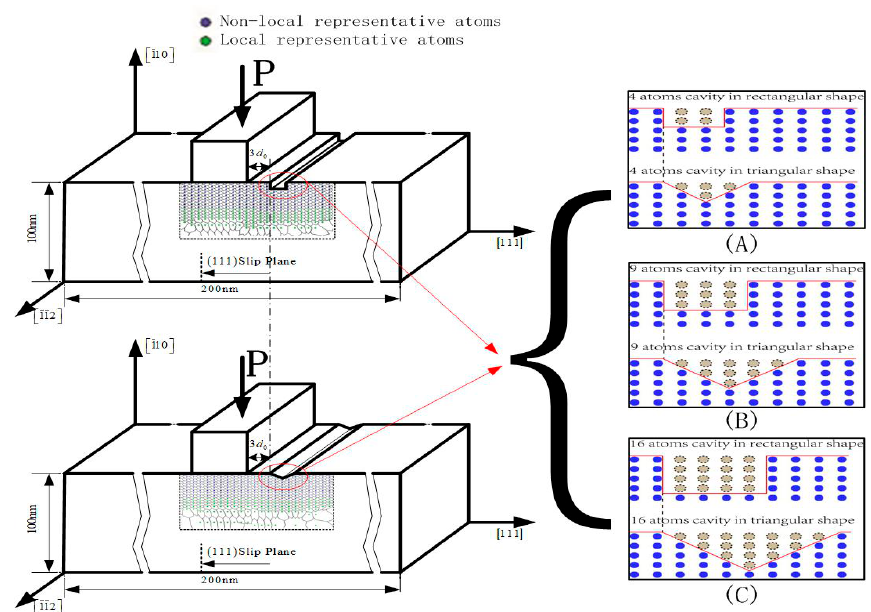
Figure 1. The schematic illustration of nanoindentation model with defects of a rectangular shape or triangular shape. ( A ) comparison model of defects with 4 atom cavity; ( B ) comparison model of defects with 9 atom cavity; ( C ) comparison model of defects with 16 atom cavity.